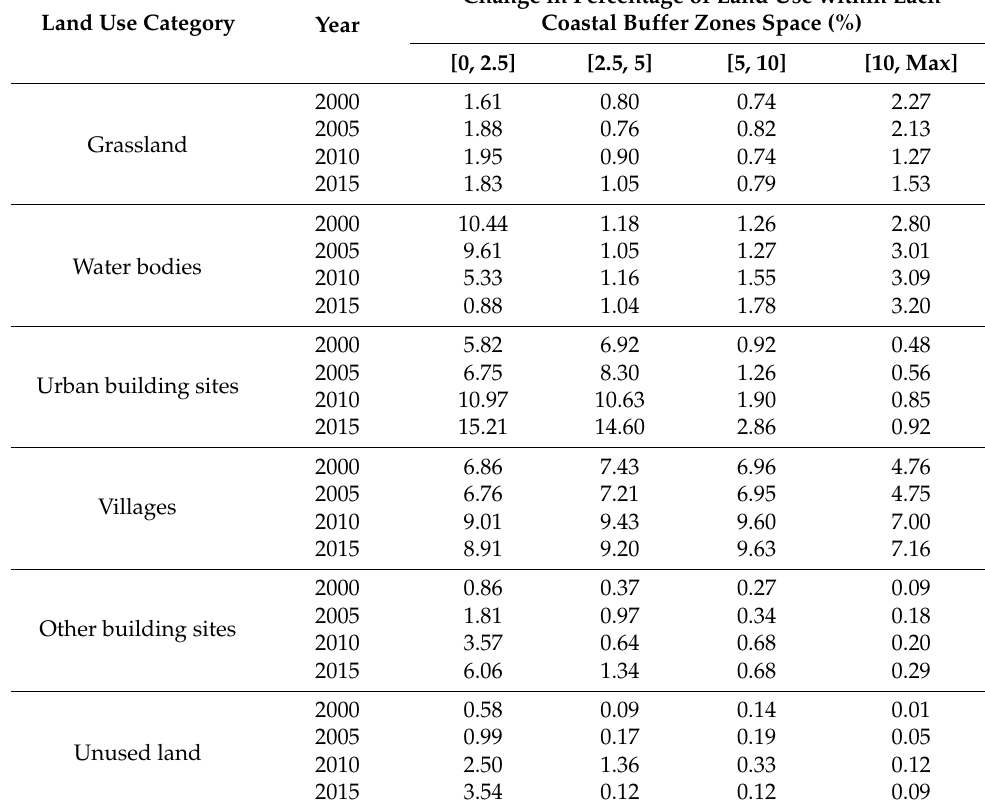
Table 3. Cont . Land Use Category Year